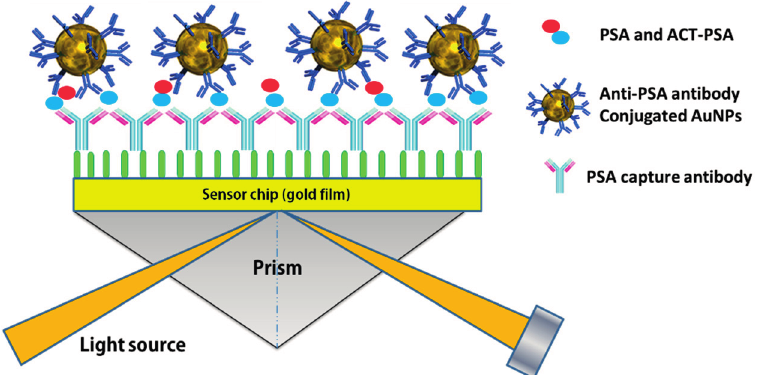
Figure 4. Schematic representation of the PSA immunosensor based on PSA detection antibody-modified Au nanoparticles using surface plasmon resonance